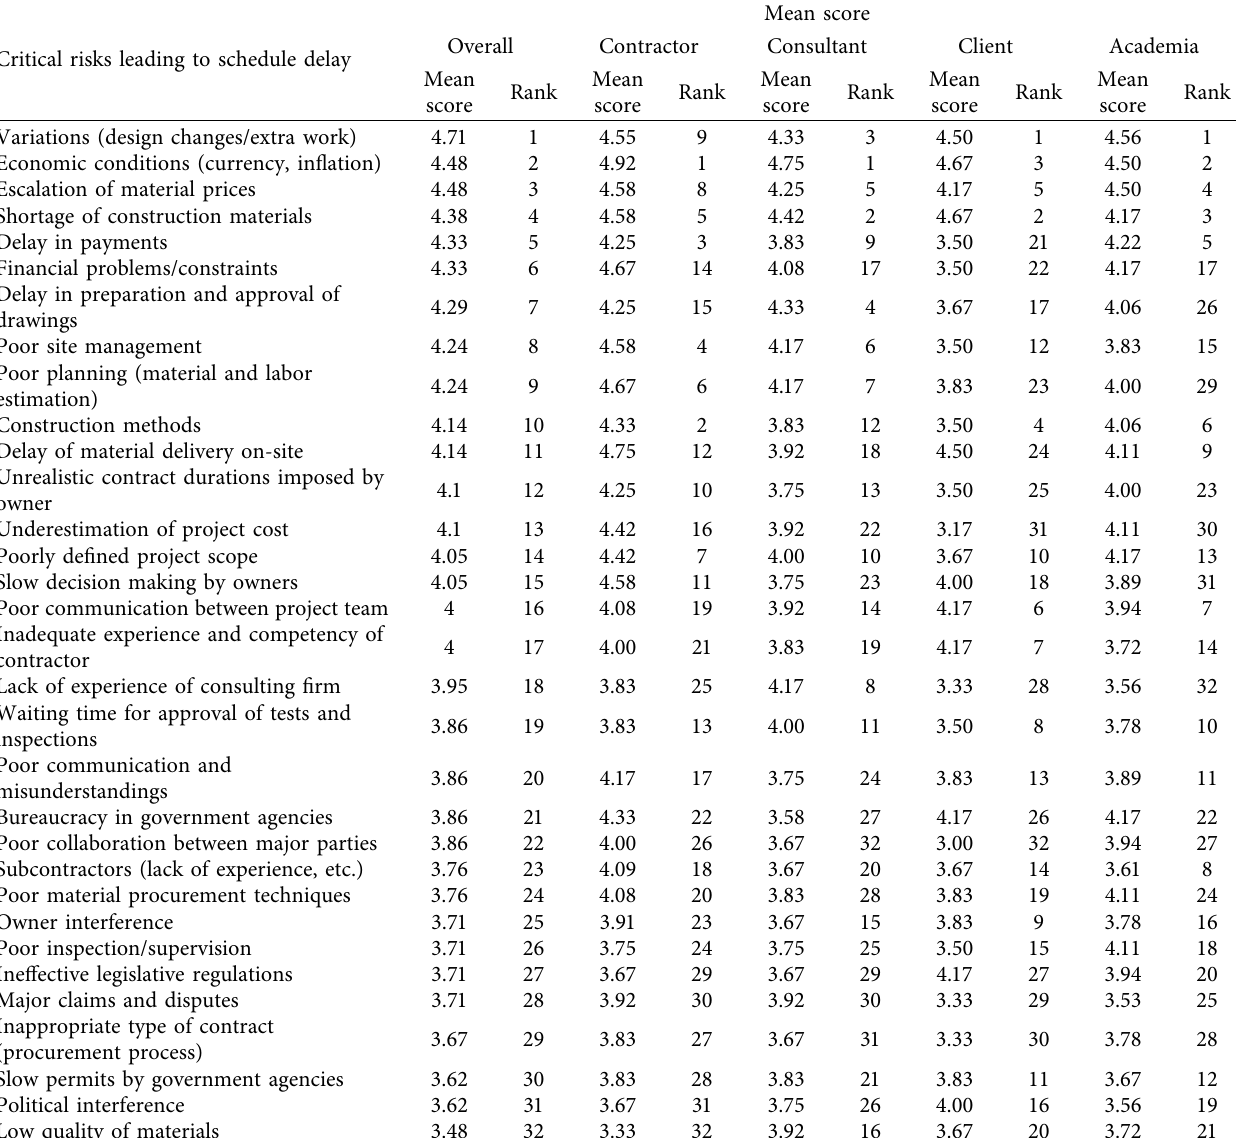
Table 8: Critical risks leading to schedule delays in construction